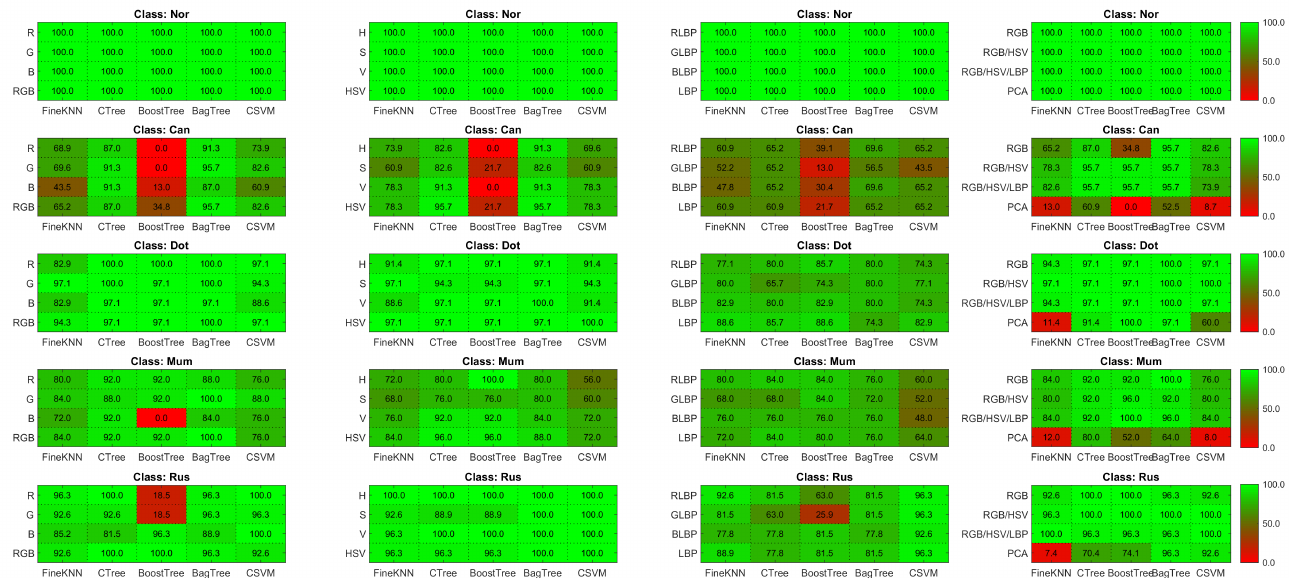
Figure 7. Illustration of heat-maps TPR comparison using RGB histogram, HSV histogram, LBP and hybrid feature vectors for Guava disease